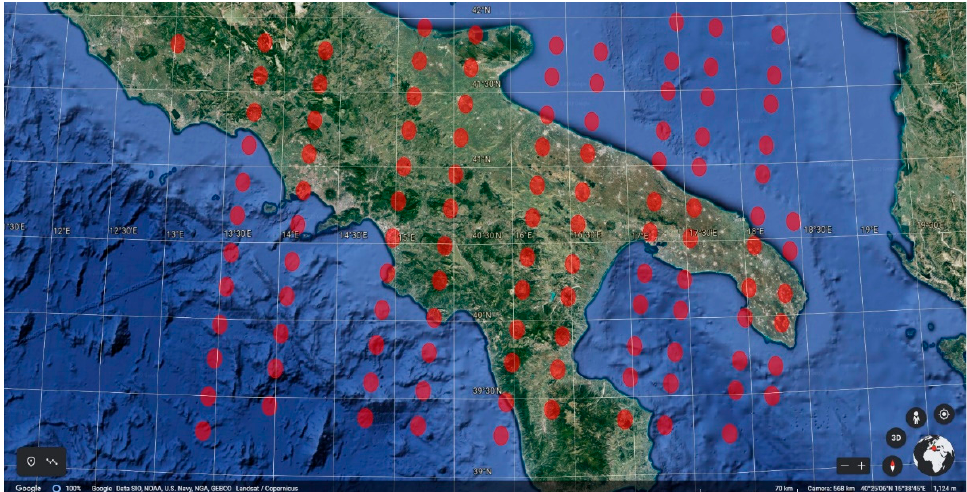
Figure 4. Target region showing the IASI footprint scan pattern (red ovals) for one single overpass.